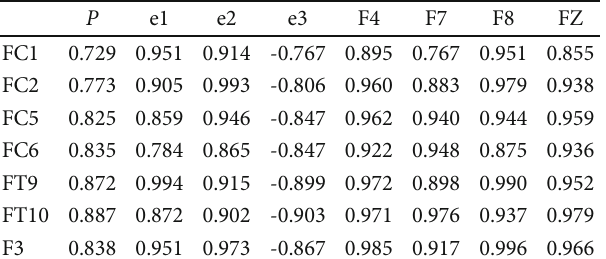
Table 3: Correlation analysis data